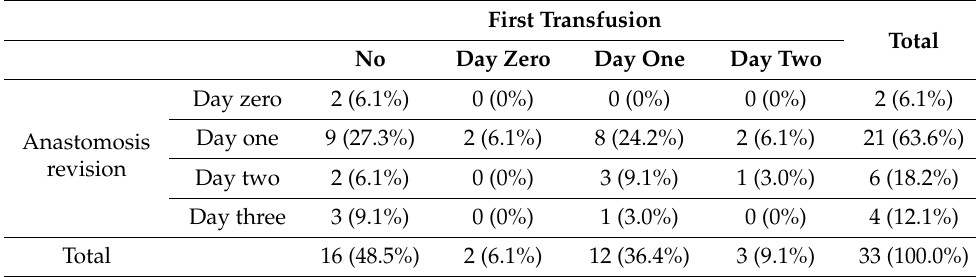
Table 3. Relationship between the day of the first transfusion and the day of the anastomosis revision.